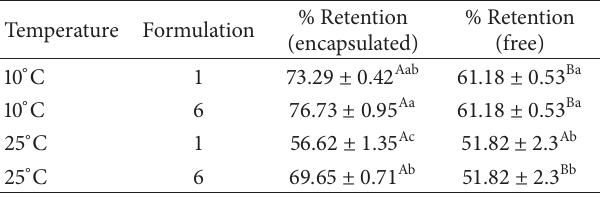
Table 3: Retention of lycopene in microcapsules and in free form after 73